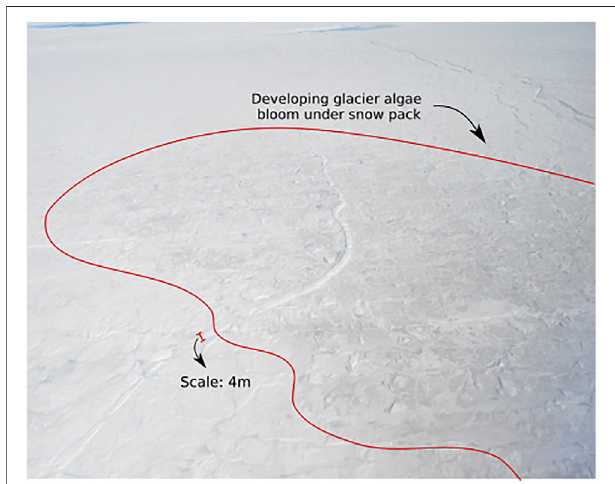
FIGURE 1 | The onset of glacier algal blooms near the snowline in the vicinity of the K-Transect, SW Greenland ( Figure 2A ). The snow- fi lled supraglacialchannel running centreimage through thebottom lefthasawidth of ~4 m for scale. It is evident that glacier algae (encircled by red line) are darkening the surface even as the last snow is